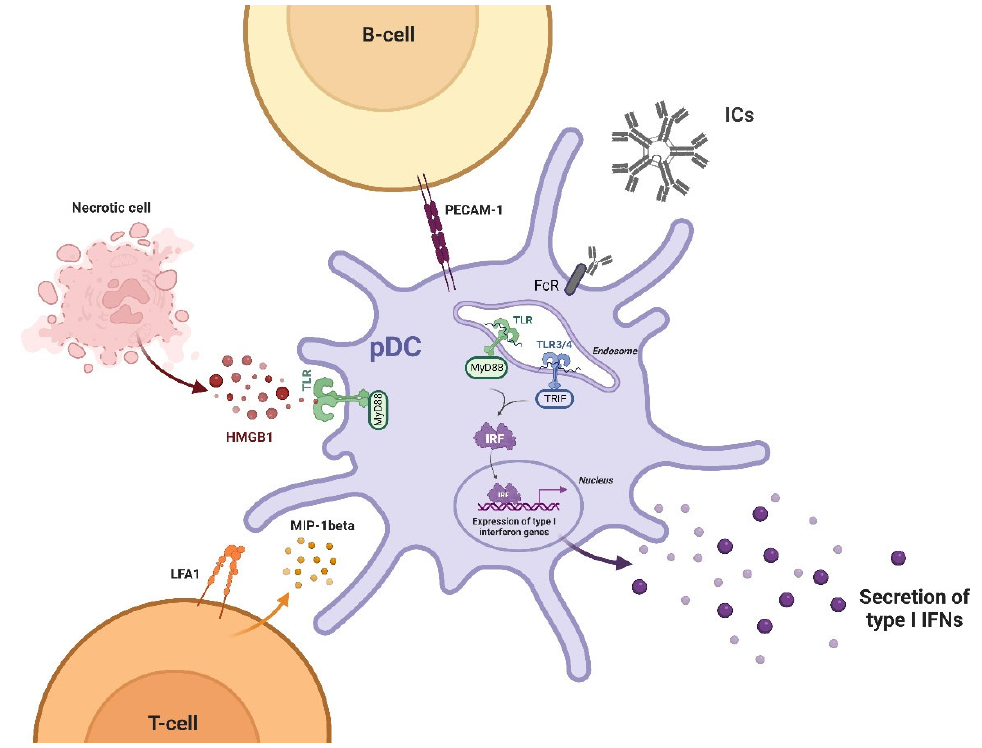
Figure 2. Regulation of INF α production by plasmacytoid DCs.